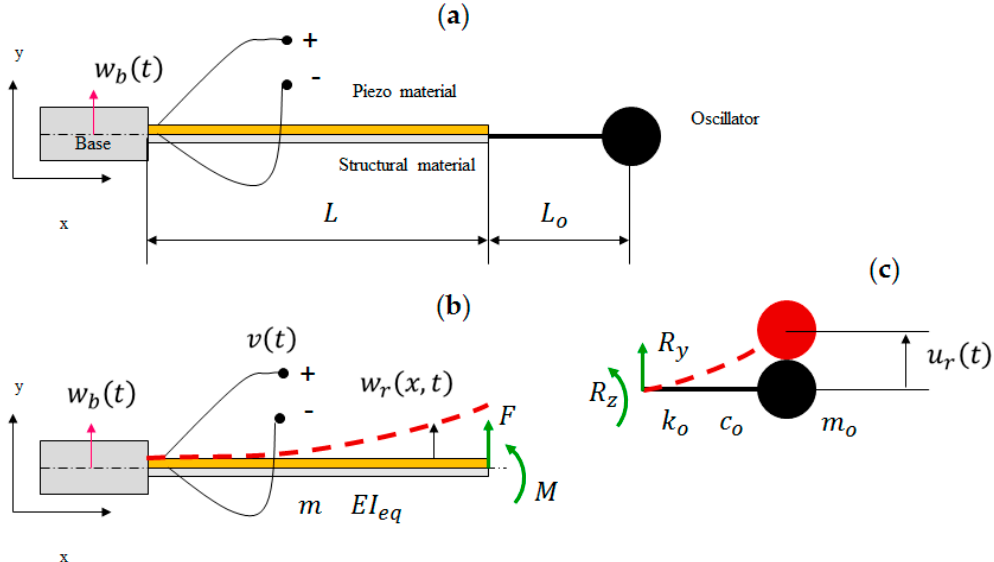
Figure 4. Scheme of the cantilever harvester with oscillator. ( a ) Whole system; ( b ) Distributed-parameter model of the harvester, ( c ) Lumped element model of the oscillator.